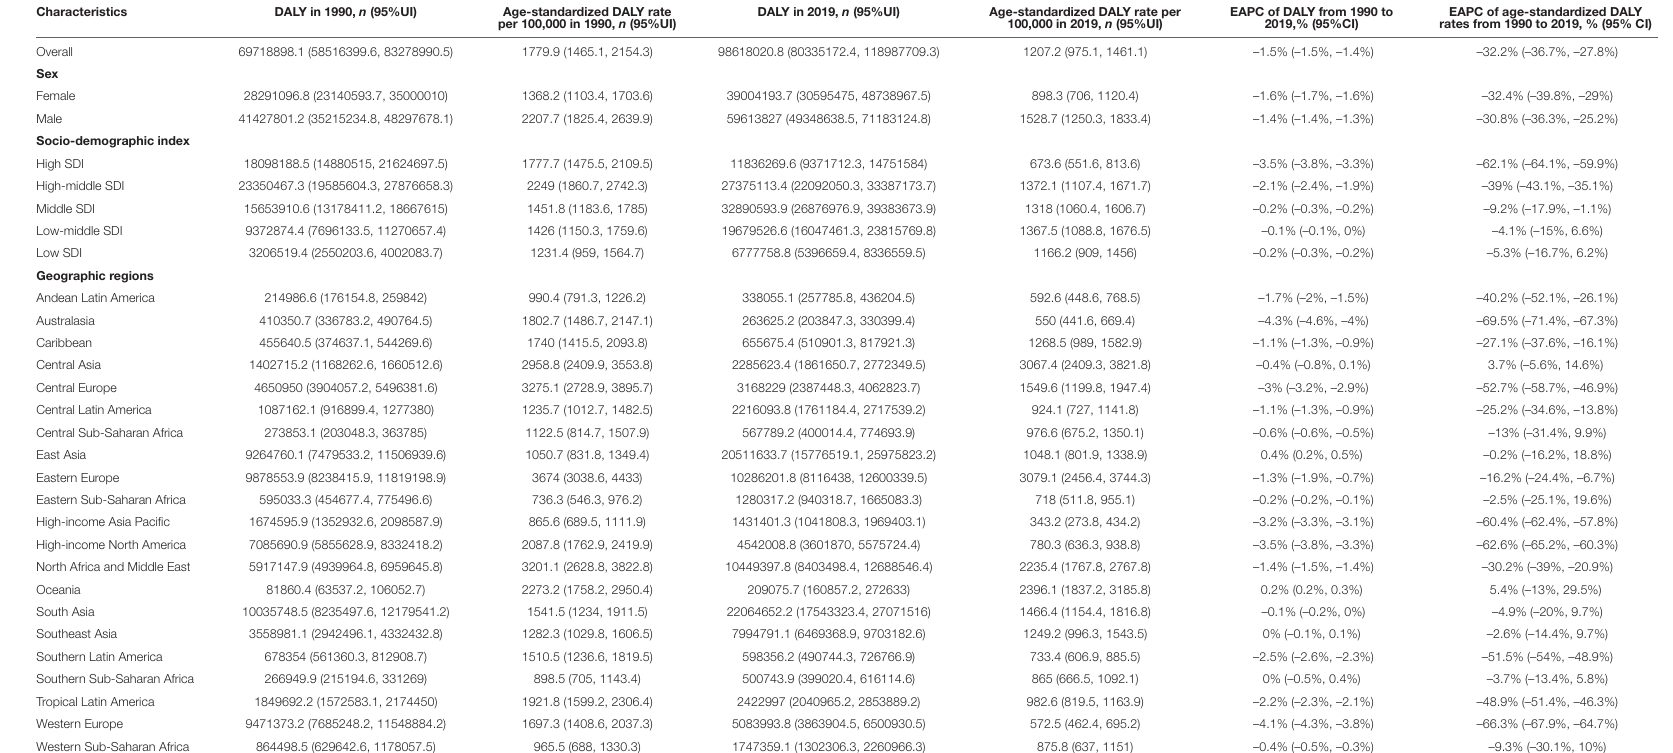
TABLE 3 | Trends of DALYs and corresponding ASR attributable to high LDL-C in 1990 and 2019.